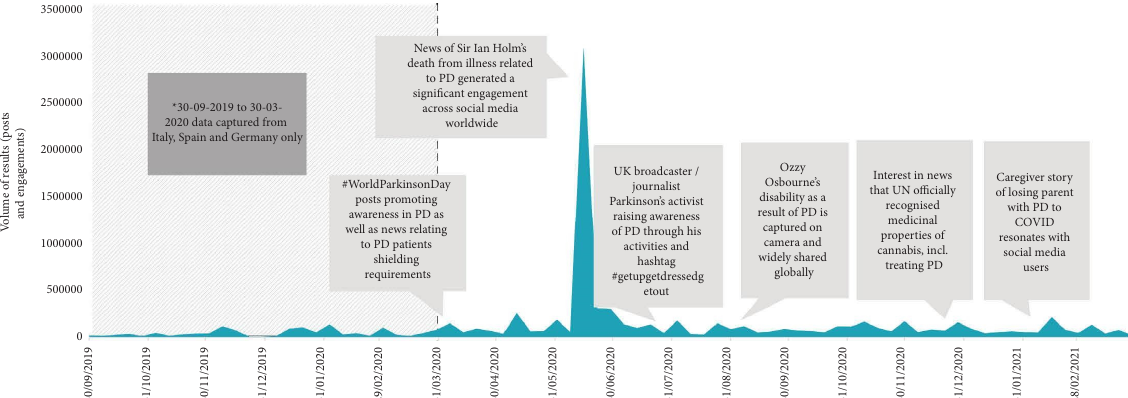
Figure 2: Overview of timing of unique posts and engagements between March 31, 2020, and March 31, 2021, for the UK and France, and between September 30, 2019, and March 31, 2021, for Italy, Spain, and Germany (total number of conversations was 392, 962). % 6 50 .